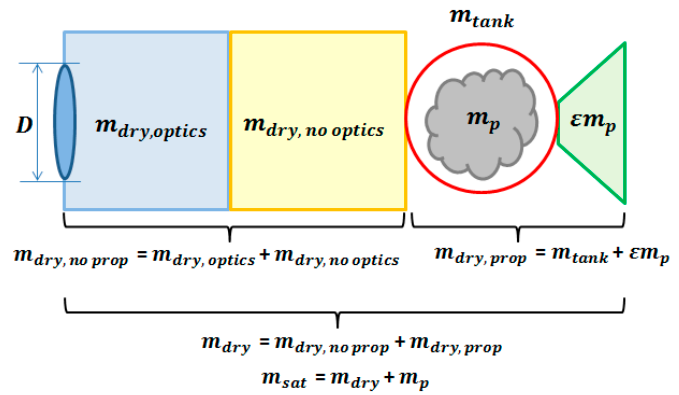
Figure 7. Mass breakdown of a ReCon satellite.